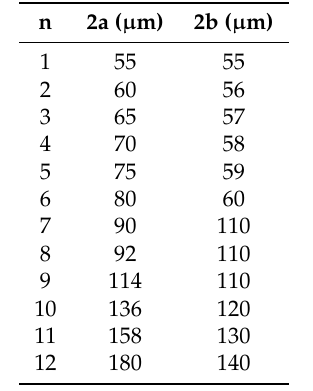
Table 1. Sunflower’s dimples